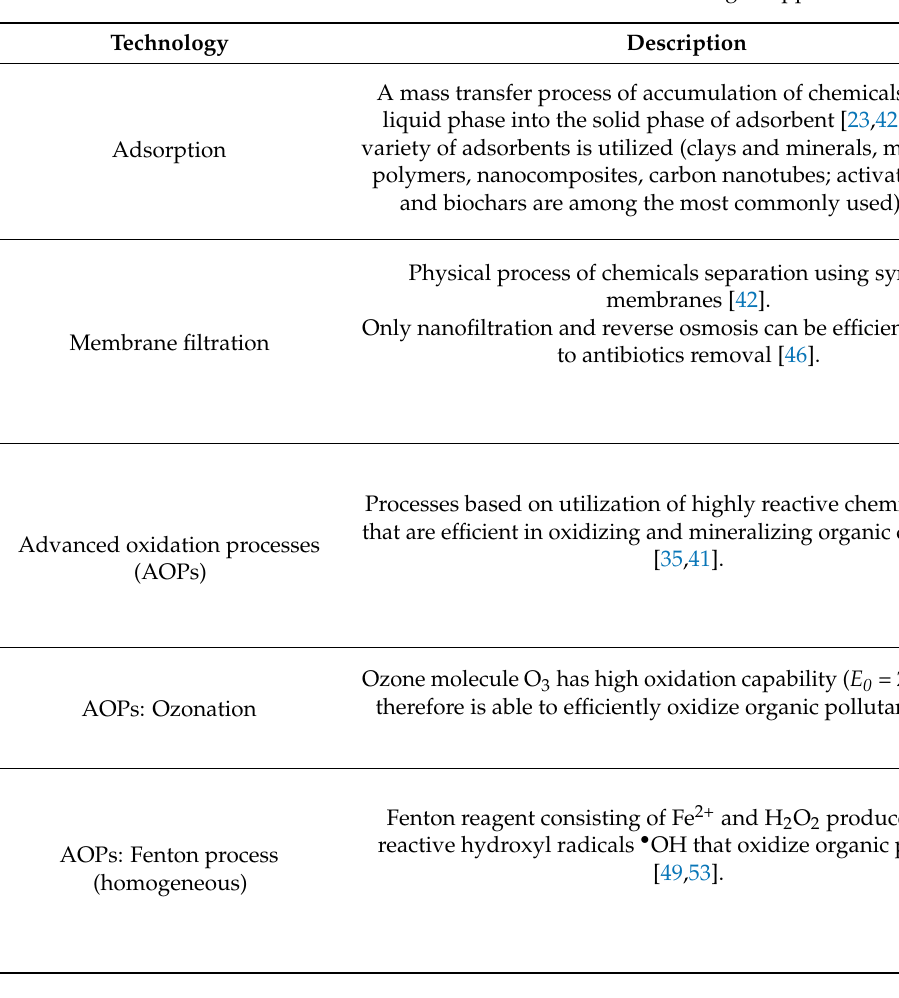
Table 3. Advanced technologies applied to the treatment of wastewater contaminated with